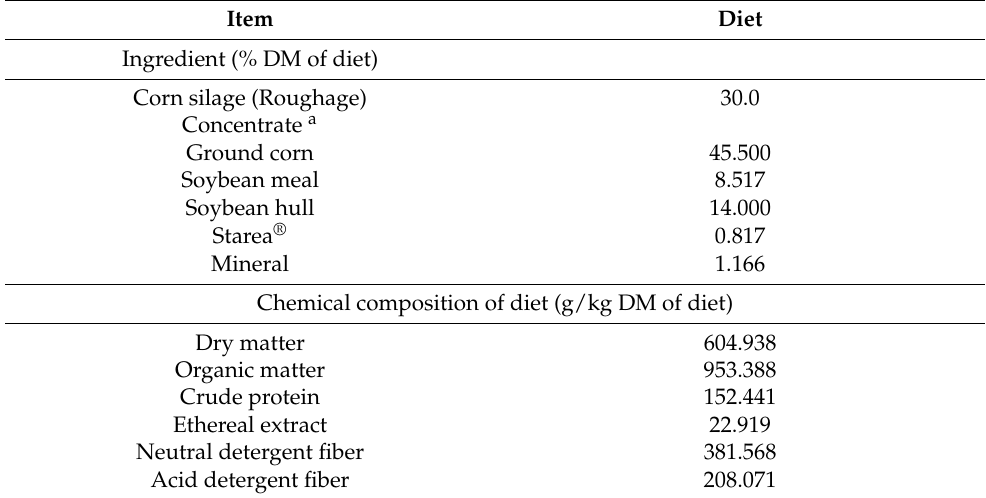
Table 1. Composition of experimental diet offered to steers without the feed